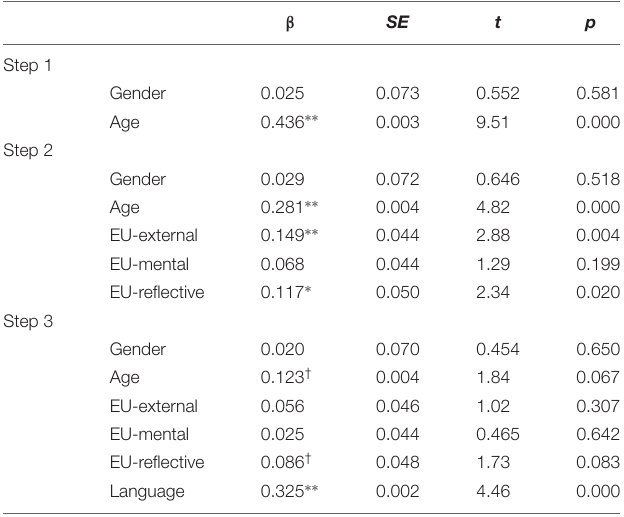
TABLE 3 | Regression outcomes (standardized beta weights ) for target variable ToM ( N = 389).